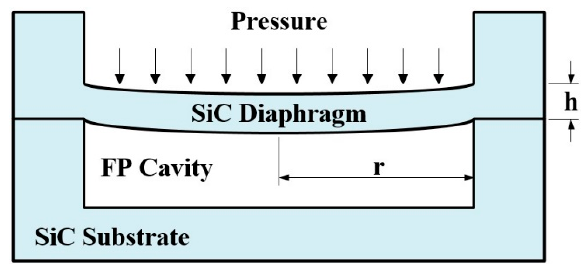
Figure 2. Deflection of a rigidly clamped flat diaphragm under uniform pressure.